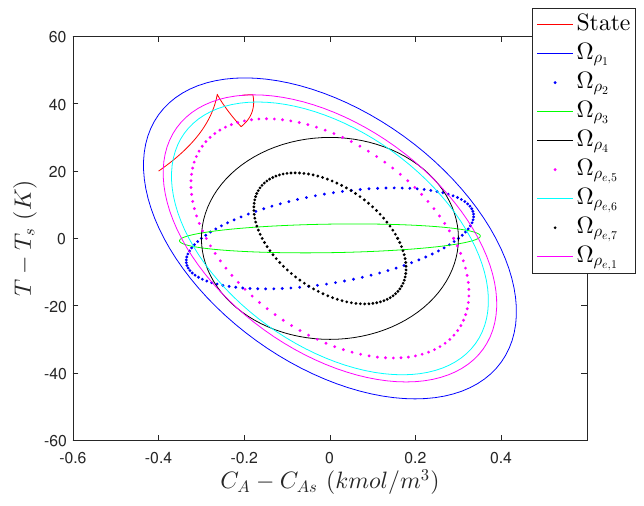
Figure 6. State-space trajectories under the single LMPC for the CSTR of Equations (46) and (47). The figure indicates that the closed-loop trajectory settled on the boundary of Ω ρ to optimize the e ,1 objective function while meeting the constraints. For simplicity, only one level set for each of the n p potential LMPC’s is shown ( Ω ρ is shown if V i (cid:54) = V 1 , and Ω ρ is shown if V i = V 1 , i > 1). i e , i